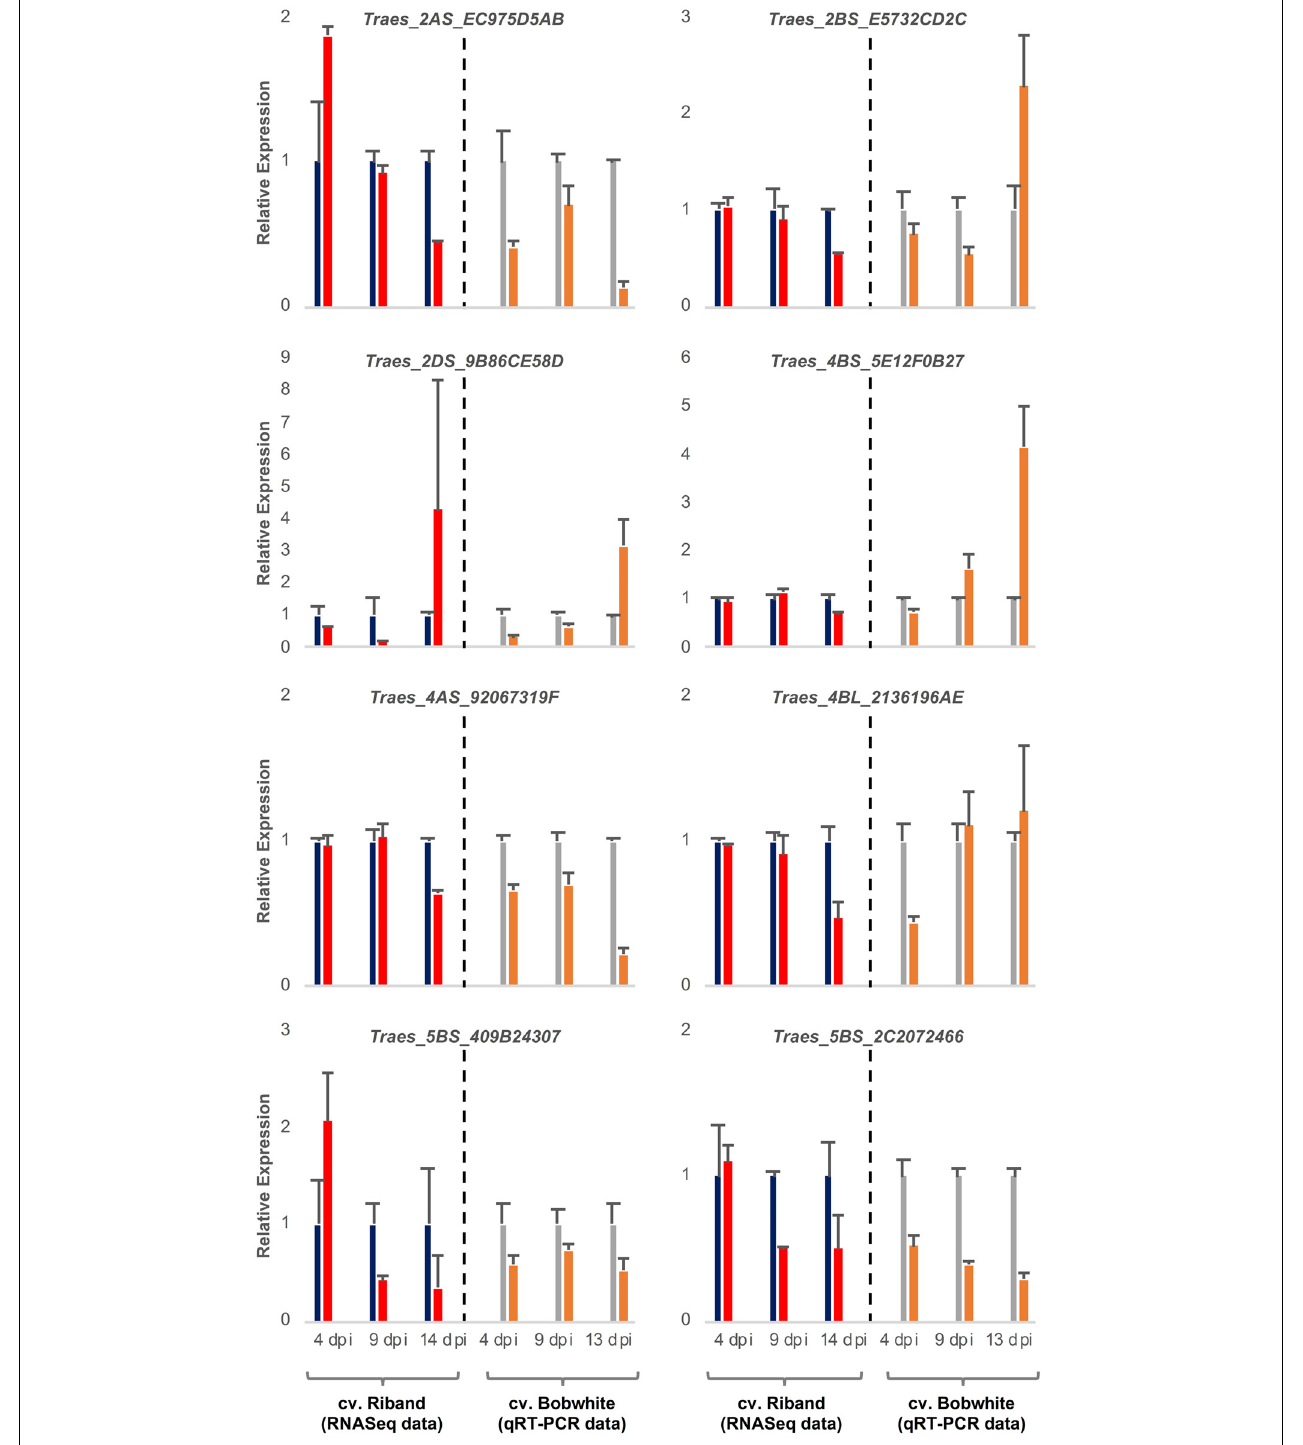
FIGURE 3 | Expression profiling of eight candidate wheat target mRNAs during Zymoseptoria tritici IPO323 infection of wheat cv. Bobwhite leaf tissue. Left panels show RNAseq data [re-analysis of Rudd et al. (2015)] for candidate genes converted to relative expression for presentation for mock (blue) and Z. tritici IPO323 (red) treatments. Right panels show qRT-PCR analysis of duplicate sample set, mock (gray) and Z. tritici IPO323 (orange). Expression levels were rescaled such that the mock infection treatment at each timepoint represents a value of 1. There were 3 biological replicates in this experiment. Bars indicate SE.